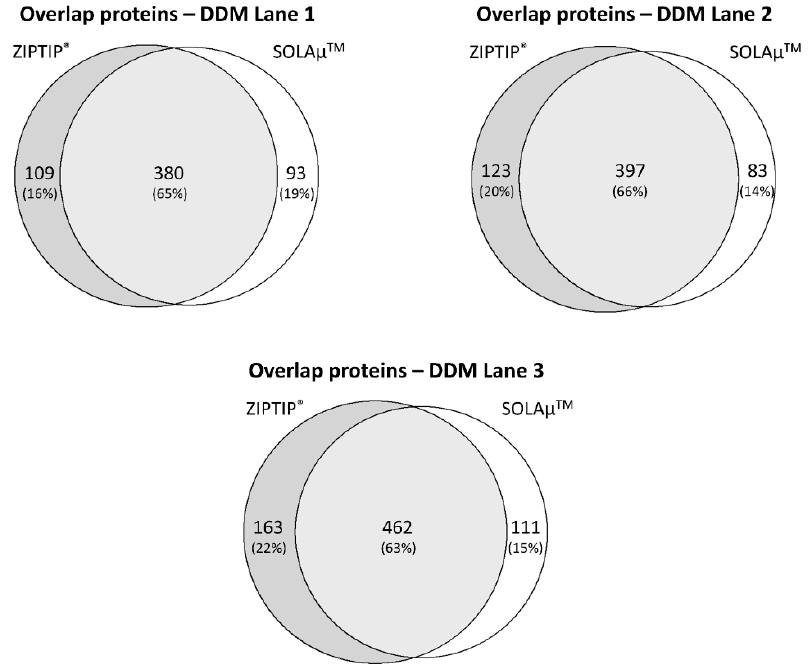
Figure 4. Venn diagram showing the overlap (percentage distribution) of identified proteins in the DDM fraction between six technical replicates. Three technical replicates were either purified by ZIPTIP ® pipette tips or SOLAµ TM microtiter plates. On average 65 ± 2% of all identified proteins were detected with both SPE-based purification methods.